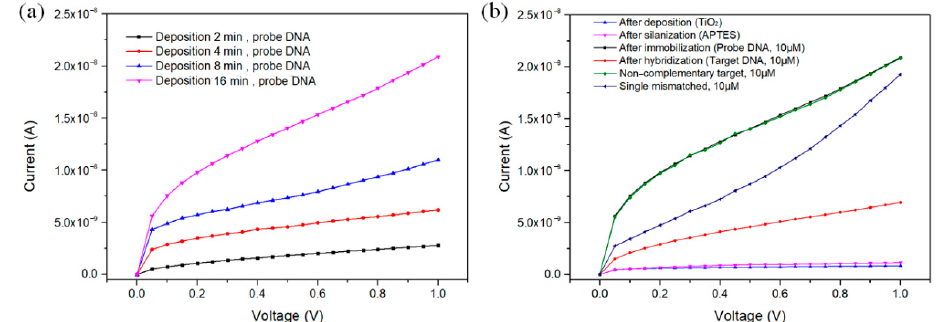
Figure 6. ( a ) Dependence of the TiO 2 NPs deposition time on the responses of the sensor. ( b ) Current responses of each Pt IDE after TiO 2 deposition, silanization, and DNA immobilization, and current responses according to the reaction between the fabricated DNA sensor and different DNA.